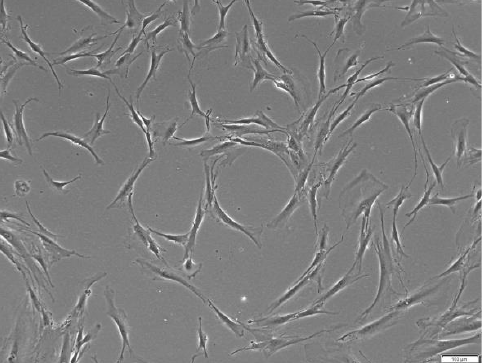
Figure 2. Representative image of HGF-1 cells cultured in DMEM medium supplemented with 10% fetal bovine serum before the exposure to HAp-based coatings. Scale bar: 100 µm.